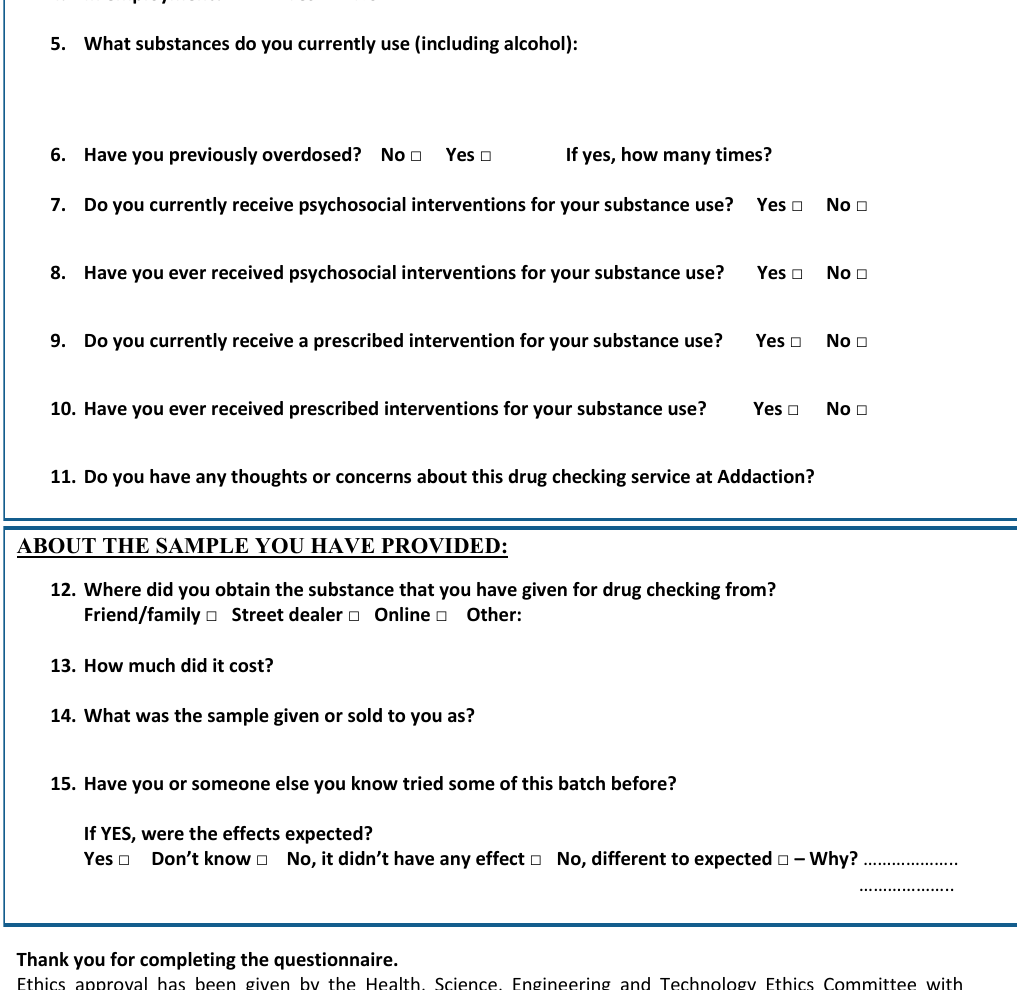
Figure A1. Questionnaire for clients, completed by the client, whilst awaiting the result of their sample analysis and used when delivering the tailored harm reduction intervention.